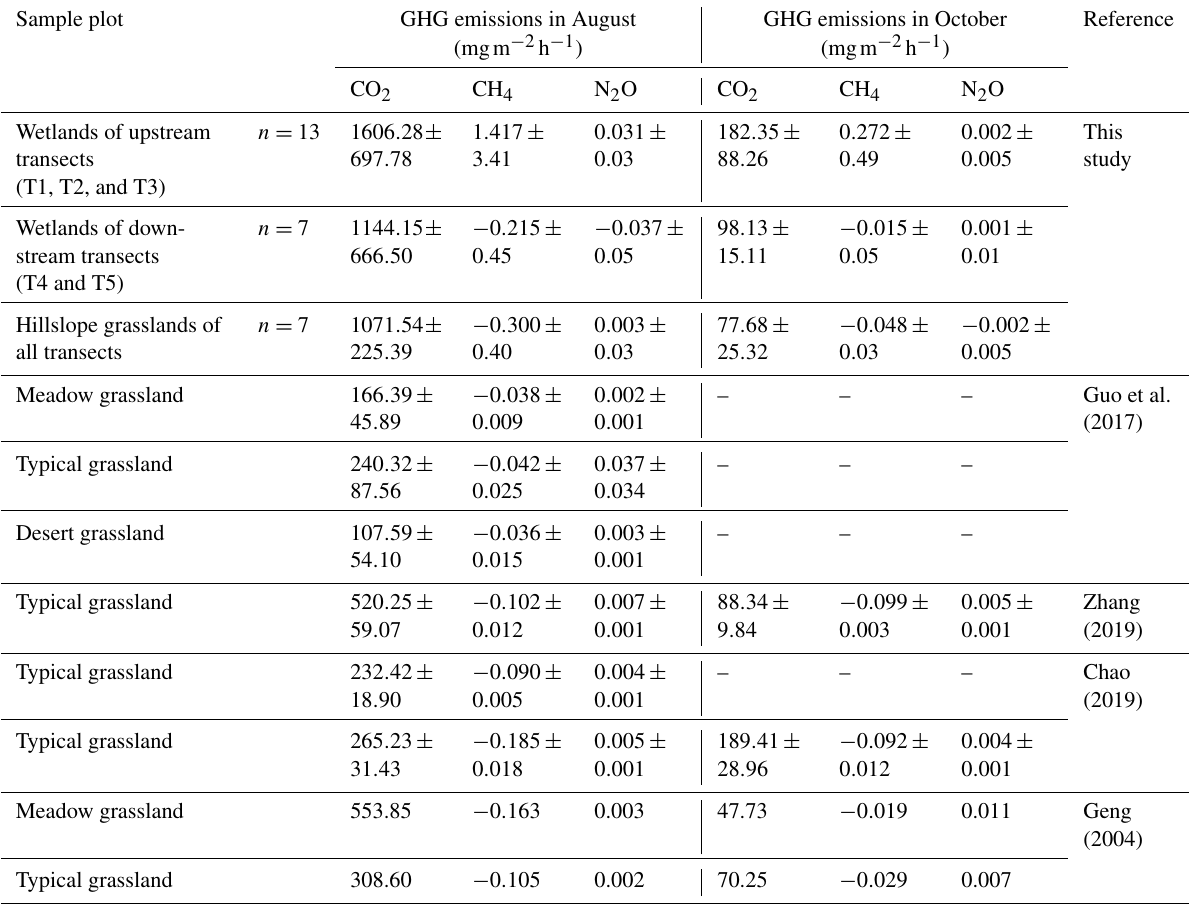
Table 5. GHG emission fluxes of riparian wetlands and grasslands. Sample plot